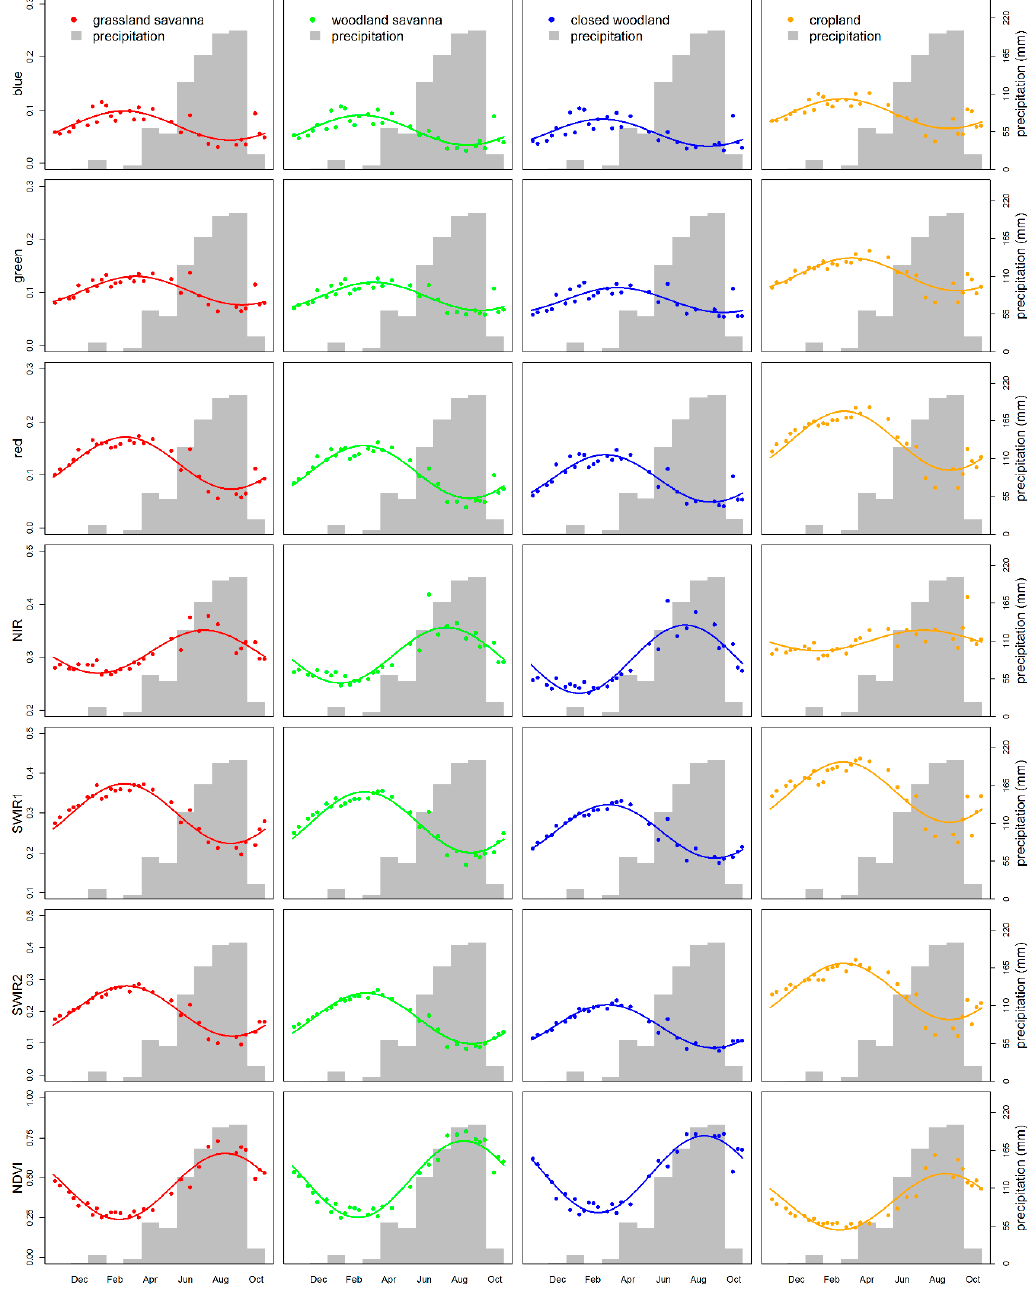
Figure 6. Seasonal variation of reflectance for blue, green, red, NIR, SWIR1, and SWIR2 spectral bands, NDVI and different land cover types between November 2013 and October 2014. Points represent mean values for the sample plots of the corresponding land cover types after burnt pixel removal, and lines represent fitted time series model based on the mean values. Monthly precipitation is shown in grey for comparison.